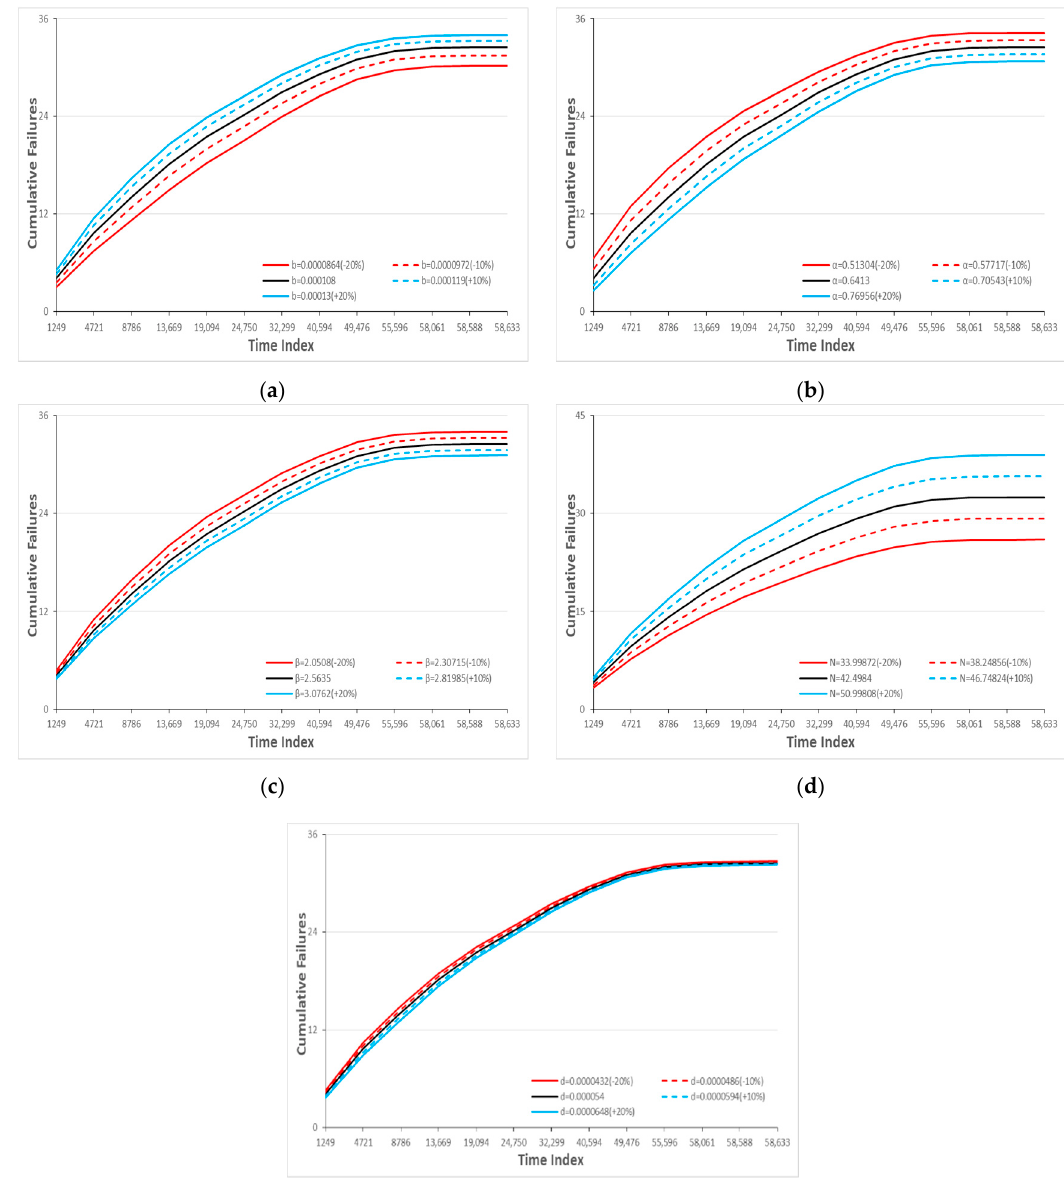
Figure 9. Sensitivity analysis of the parameters of the proposed model for dataset #1 ( a ) parameter b; ( b ) parameter α ; ( c ) parameter β ; ( d ) parameter N; ( e ) parameter d.